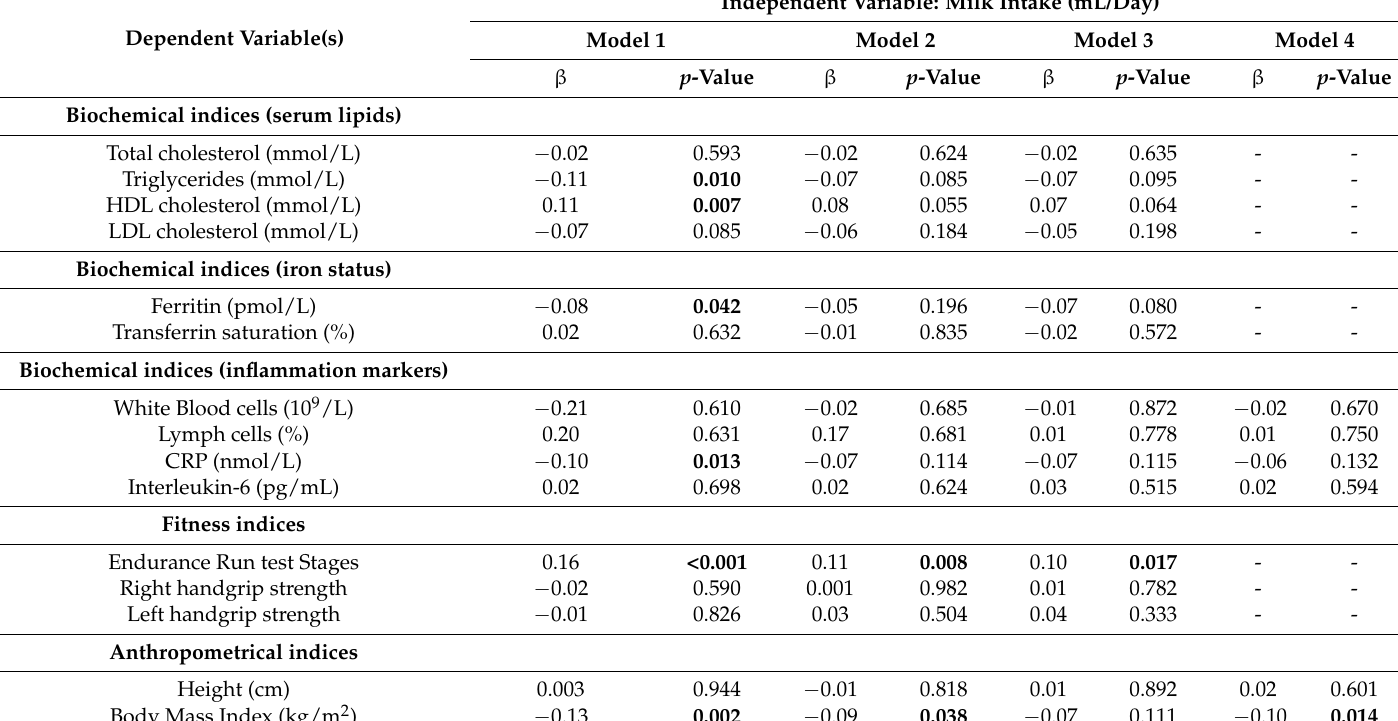
Table 2. Regression models testing the associations of milk intake with biochemical, fitness and anthropometrical indices of health status after controlling for potential relevant confounders and possible effect